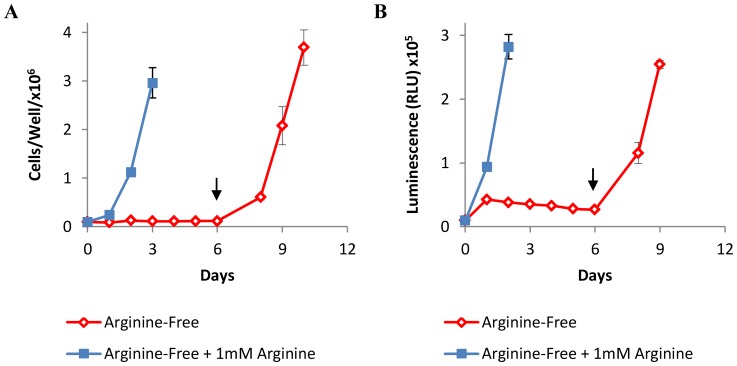
Cell viability within arginine-depleted cell populations.L1210 cells were cultured in arginine-free media with or without arginine supplementation for 6 days. Arginine was reintroduced into arginine-free cultures on day 6 as indicated by the arrows. Cell viability was determined by (A) Trypan blue exclusion, or (B) ATP quantification. For clarity, only data leading up to - and including – the maximal response is shown. Graphs show a representative experiment from three independent experiments with similar results. Error bars represent SD.